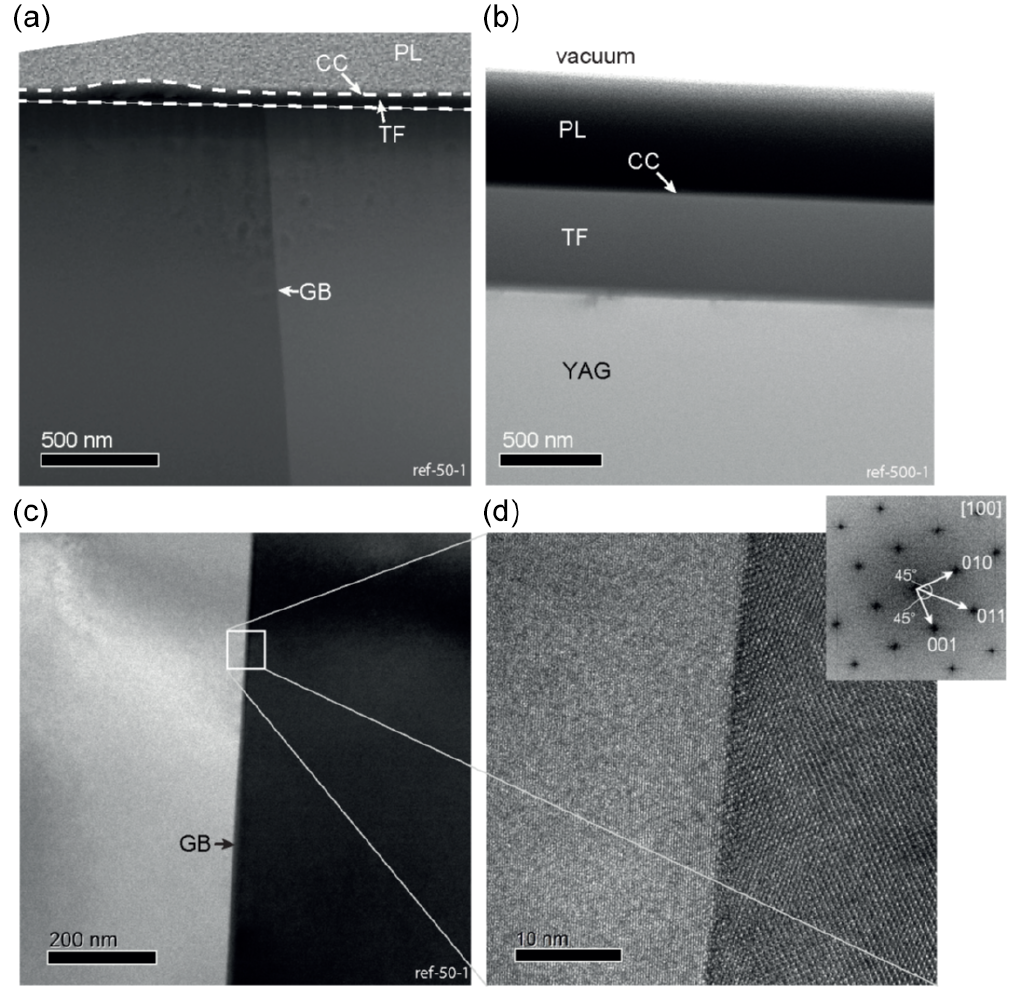
Figure 3. TEM micrographs of the reference samples. TF: thin film, CC: carbon coating, and PL: platinum layer created by FIB preparation. (a) High-angle annular dark-field (HAADF) micrograph of sample ref-50-1. The thin film is 50nm thick and amorphous. The hump on the thin film is caused by an irregularity in the carbon coating (b) bright field (BF) micrograph of sample ref-500-1: the thin film is 500nm thick and amorphous. (c) BF micrograph of the grain boundary area of sample ref-50-1. (d) HRTEM micrograph, where the right crystal is oriented along the [100] zone axis. The grain boundary is straight and does not show any holes or